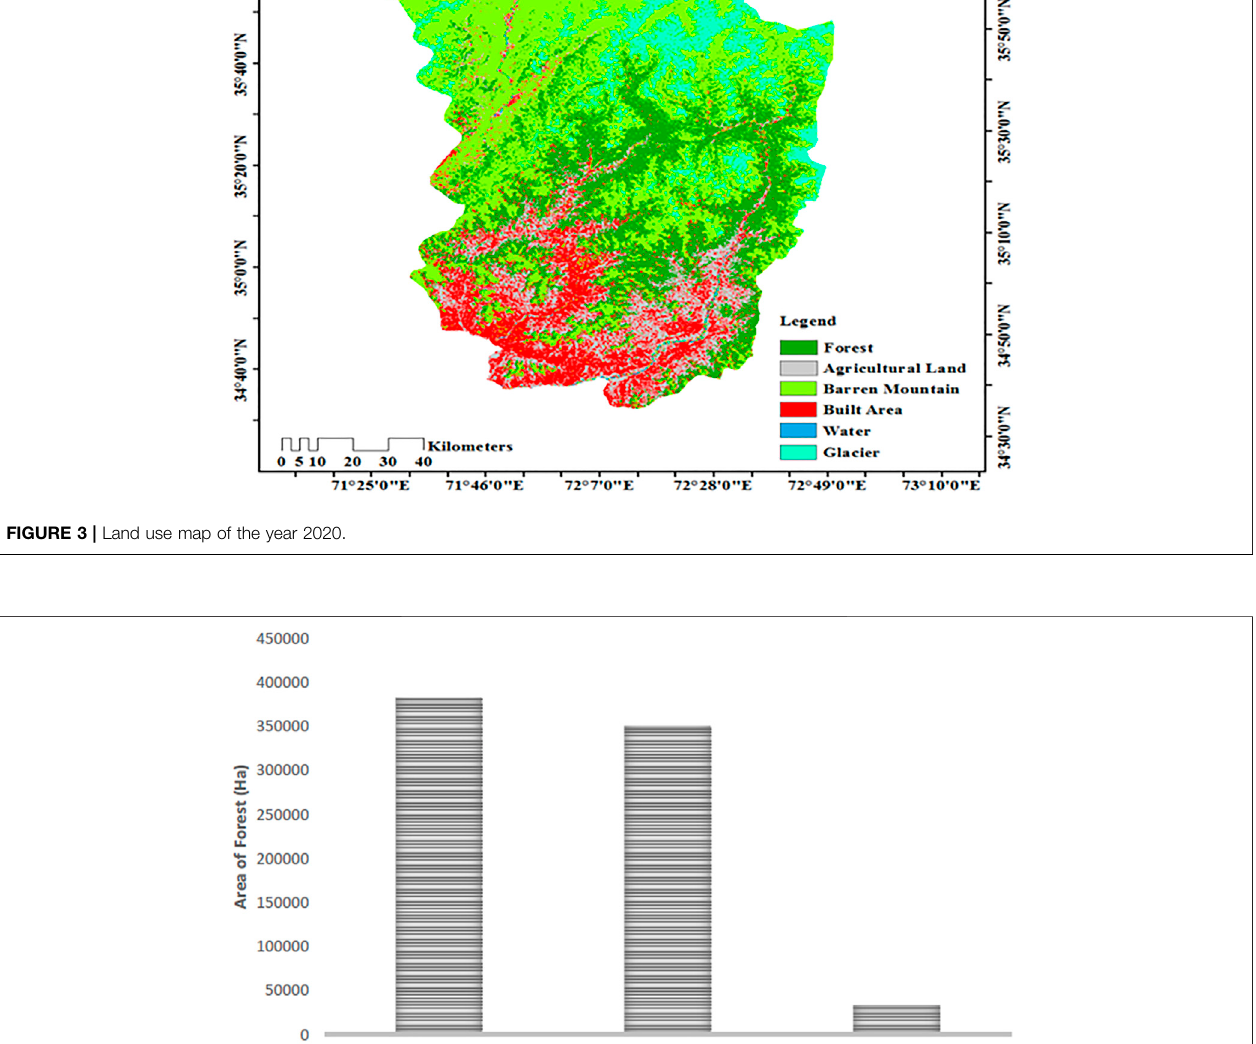
Frontiers in Environmental Science |